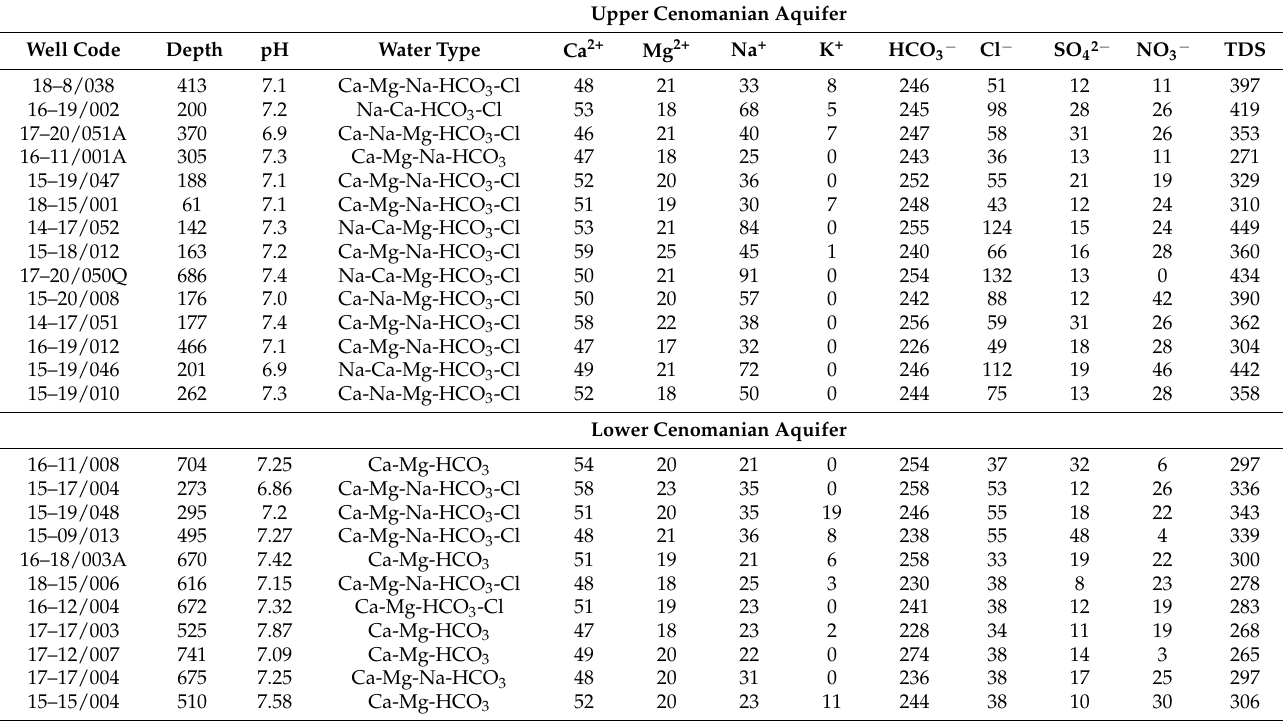
Table 3. Depth, groundwater quality, and water type for selected domestic wells tapping the Upper and the Lower Cenomanian aquifers in the West